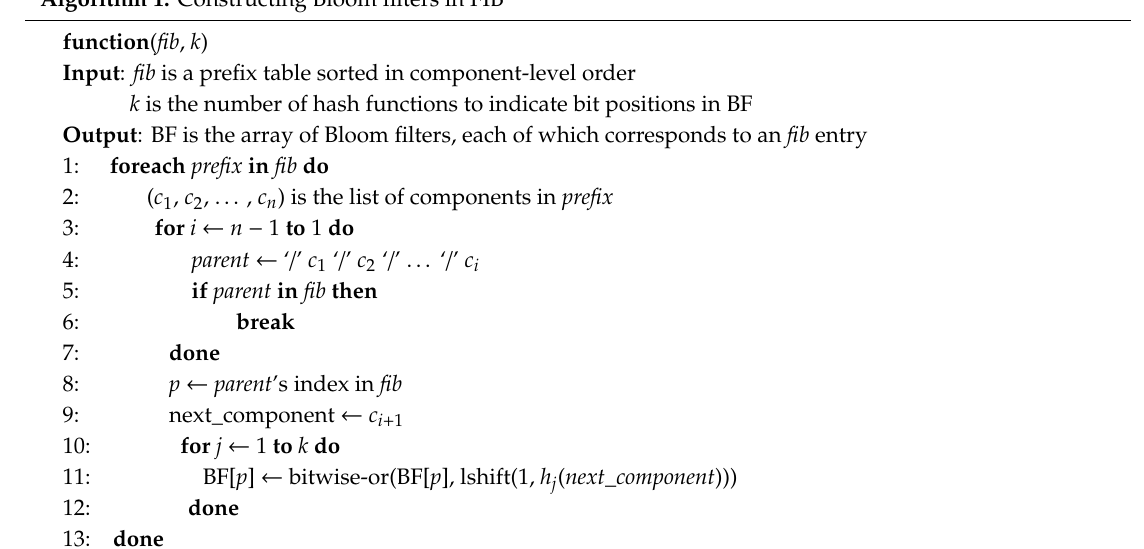
Algorithm 1: Constructing Bloom filters in FIB